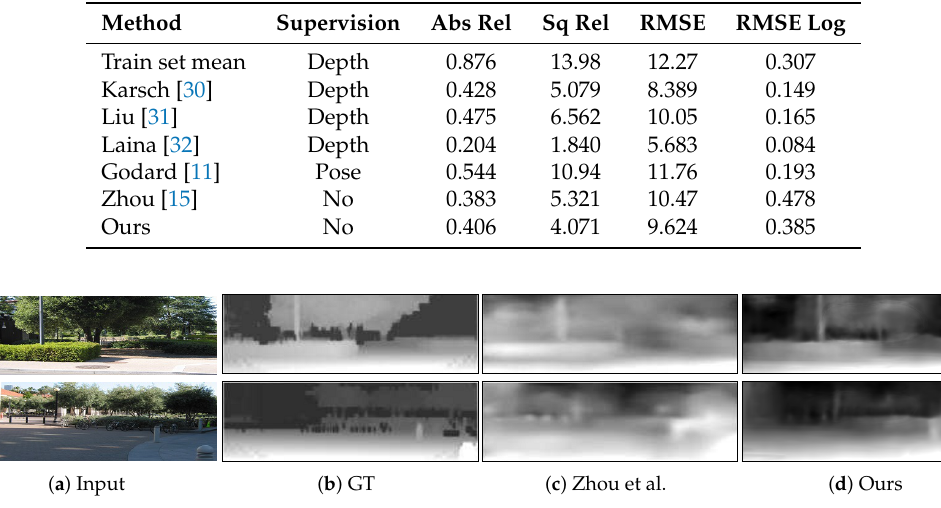
Figure 5. Comparison of monocular depth estimation between Zhou et al. [15] and ours on Make3D [29] dataset. The model is trained on KITTI + Cityscapes and tested on Make3D [29] directly. Our method captures the global scene layout reasonably well and preserves better thin